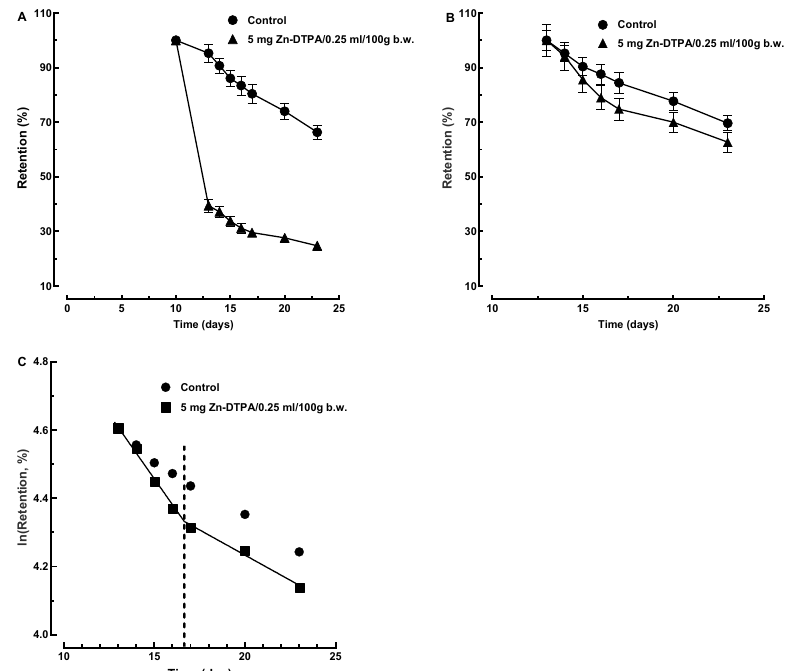
Figure 6. Time course and biphasic kinetics modeling of 65 Zn decorporation following delayed Zn-DTPA intervention (i.e., after 12 days following contamination with 65 ZnCl 2 ). ( A ) Time-course of 65 Zn decorporation following delayed Zn-DTPA intervention normalized to the retention data at day 12. ( B ) Time-course of 65 Zn decorporation by Zn-DTPA normalized to the retention data at day 13. ( C ) Two-steps linear regression of the logarithmic transformed retention data for the 13 to 23 days interval. Data represent means ± SEM ( n = 7).